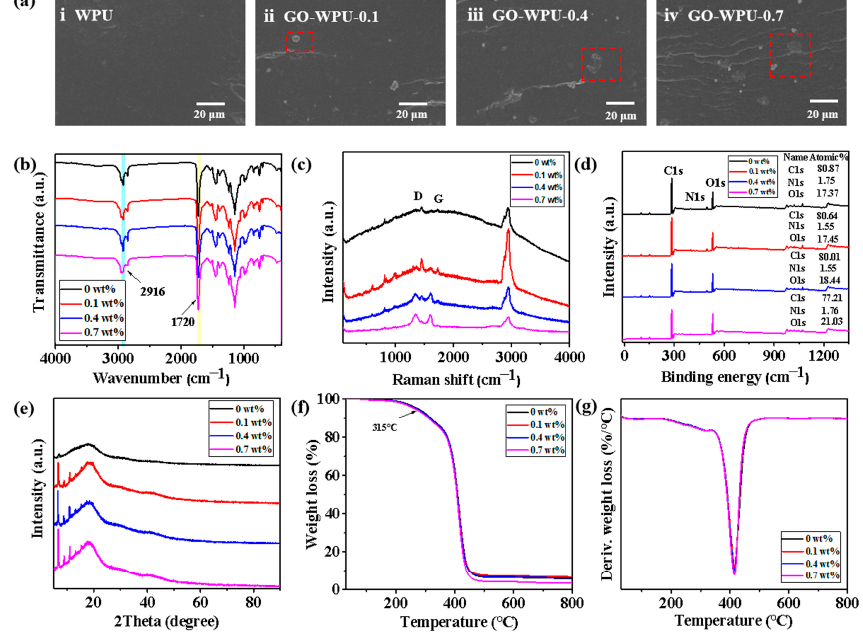
Figure 4. Effect of GO concentration on coating film performance: ( a ) SEM cross-sectional morphology, ( b ) FTIR spectra, ( c ) Raman spectra, ( d ) XPS diagrams, ( e ) XRD diagrams, ( f ) TG curves, and ( g ) DTG curves of the coating film.